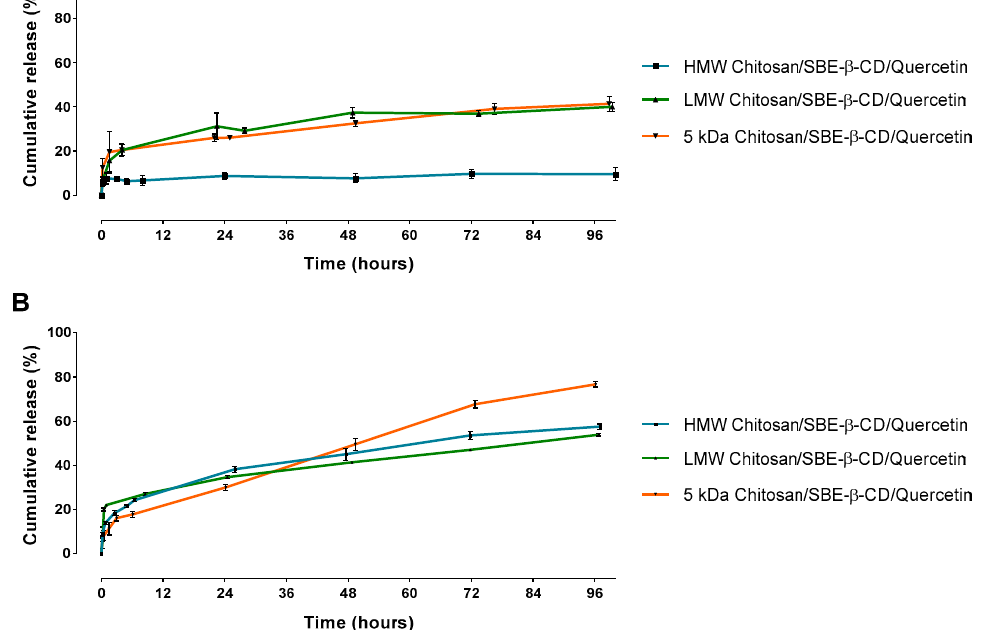
Figure 4. In vitro quercetin release studies during 96 h for each type of chitosan/SBE- β -CD/quercetin delivery systems at ( A ) pH 7.4 and ( B ) pH 5.8.